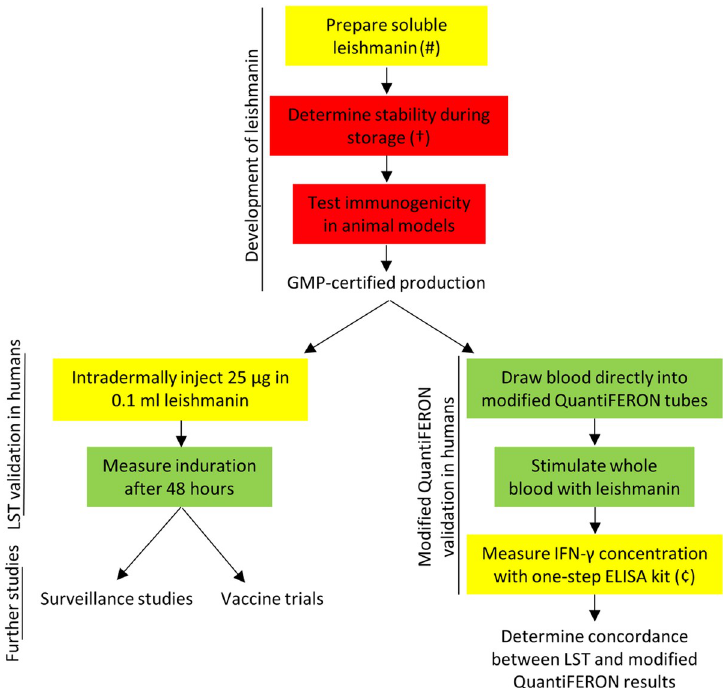
Fig 2. Steps required for the production, validation, and application of leishmanin. Green = method is standardized. Yellow = method requires confirmational studies. Red = method is not standardized. Symbols (#, †, ¥, and ¢) correspond to recommendations in Table 2. E AU : AnabbreviationlisthasbeencompiledforthoseusedthroughoutFig 2 andTable 2 : Pleaseverifythatallentriesarecorrect : LISA, enzyme-linked immunosorbent assay; GMP, good manufacturing practice; IFN- γ , interferon- γ ; LST, leishmanin skin test.